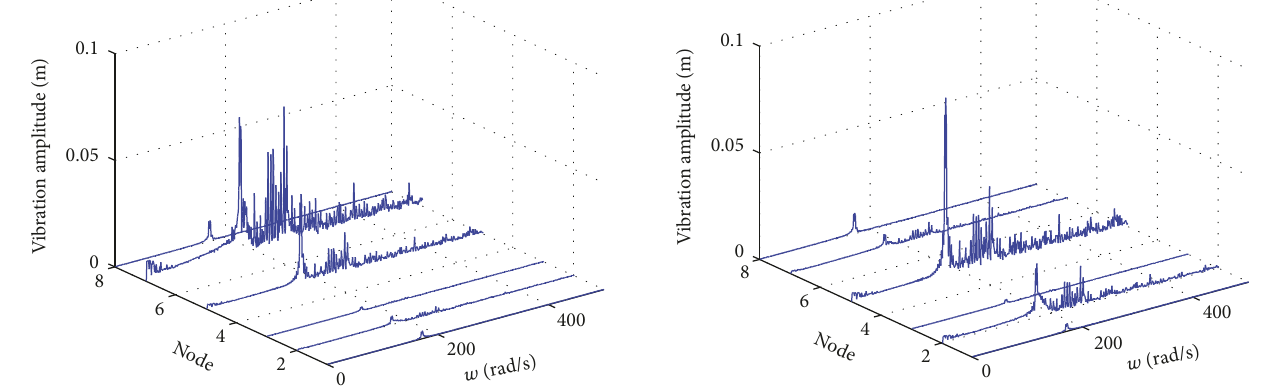
Figure 6: Nodes 2 and 8 vibrations controlled.